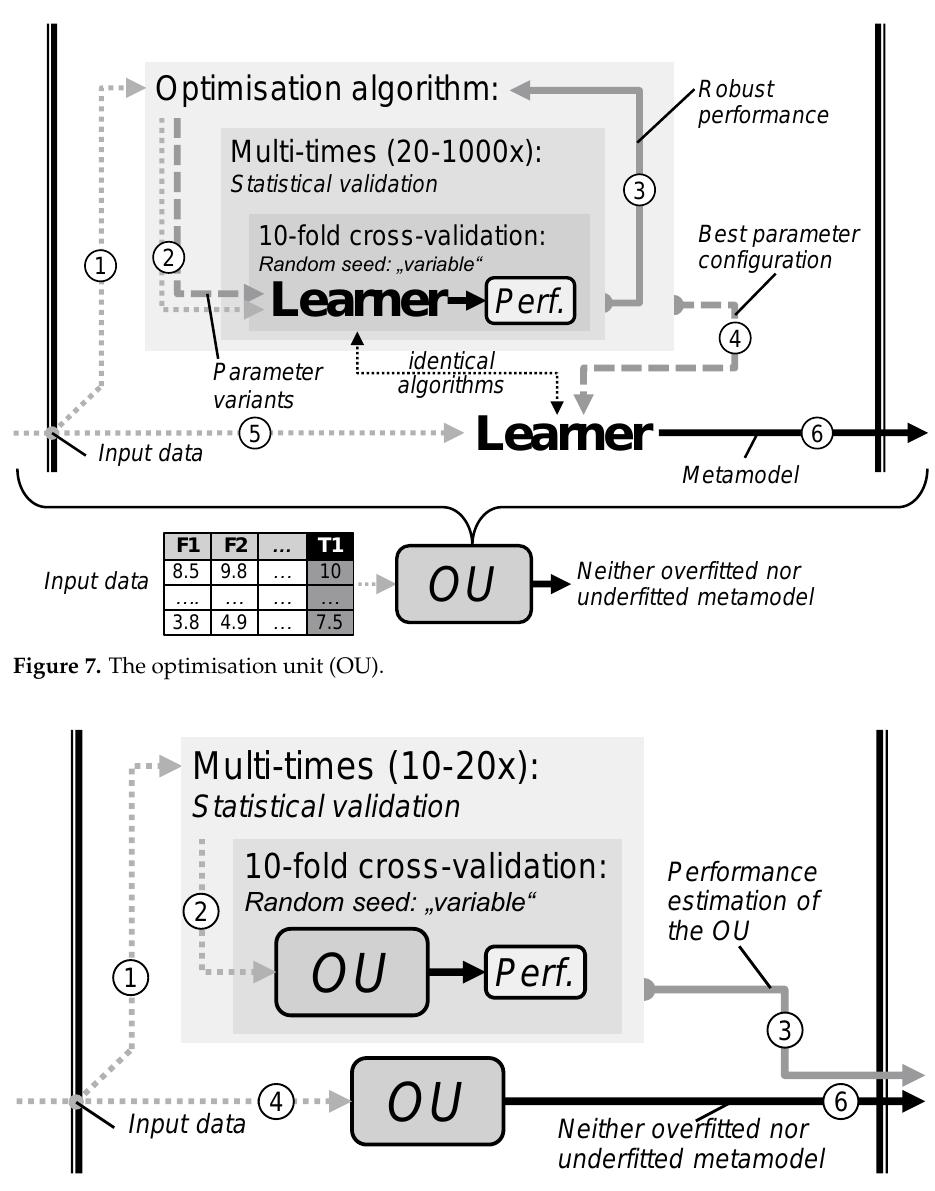
Figure 8. Reliable performance